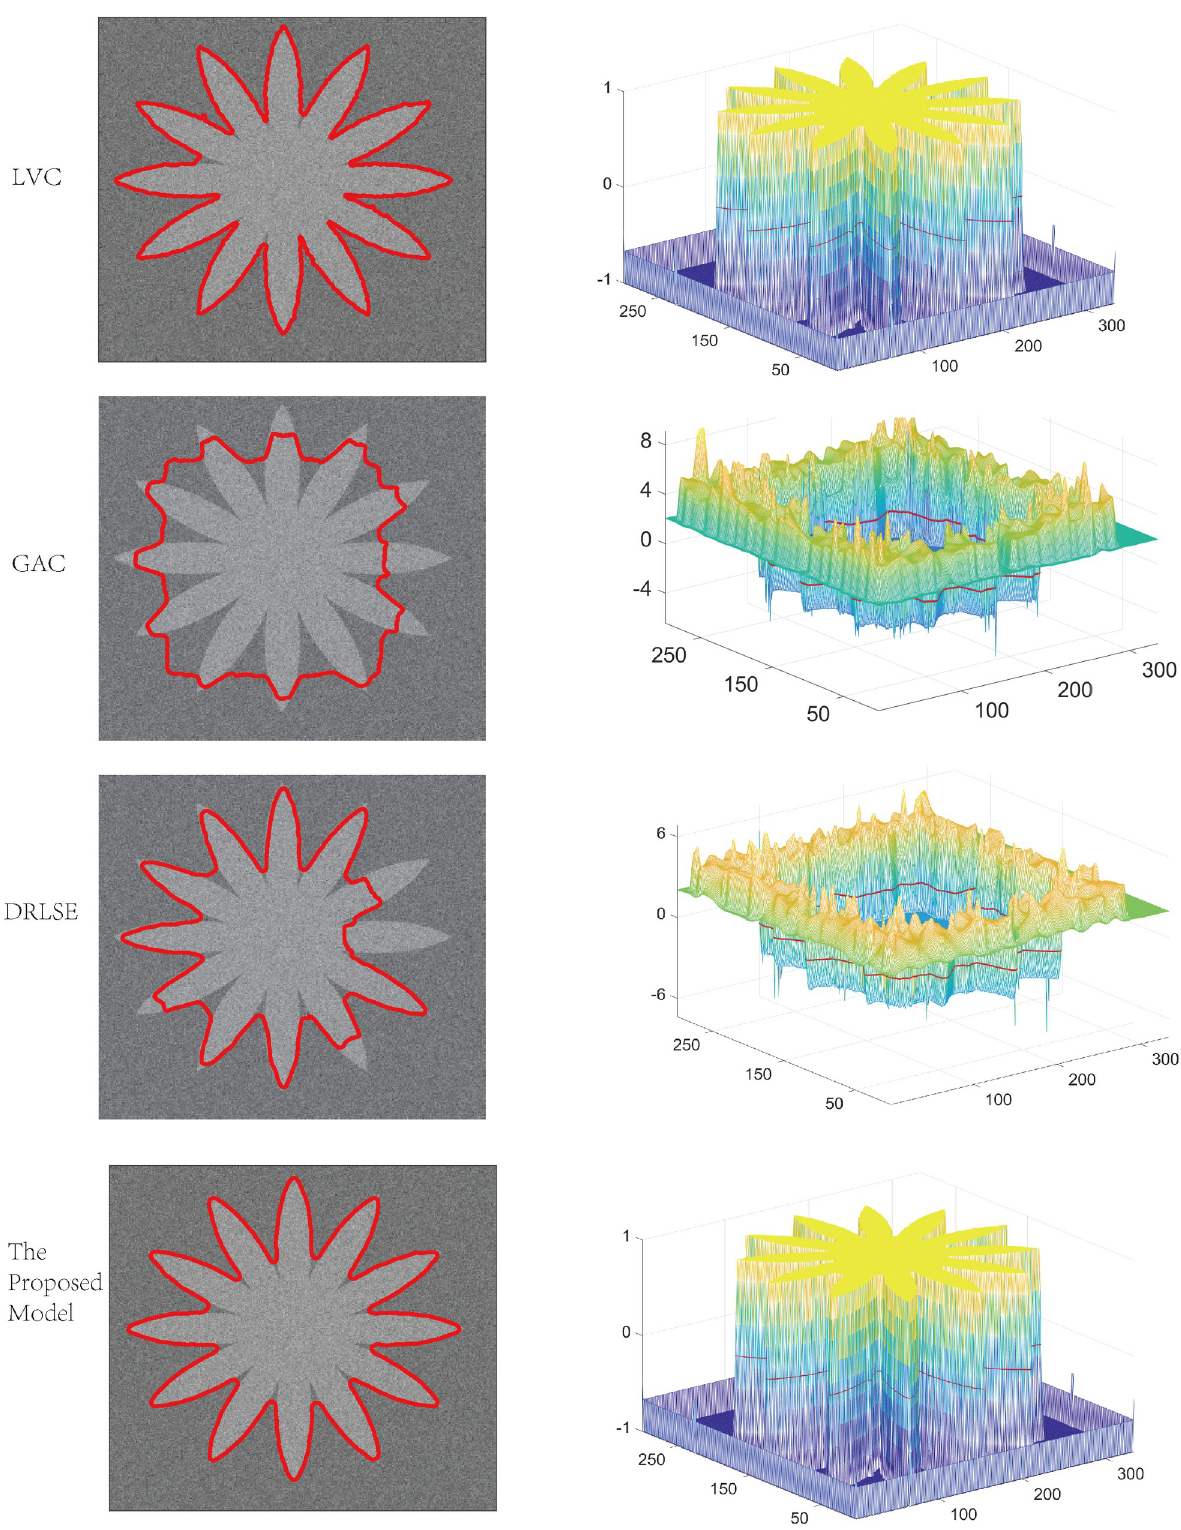
Fig 1. Comparisons of the proposed model with the LVC, GAC, DRLSE models.